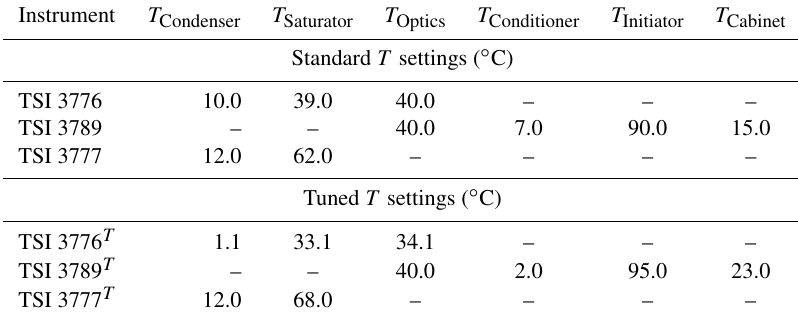
Figure 4. Detection efficiencies of the butanol-based CPCs: the figure shows the detection efficiencies as a function of the electrical mo- bility equivalent diameter. Every plot corresponds to a different butanol-based CPC: TSI 3772 (a) , TSI 3776 (b) , Airmodus A20 (c) and TSI 3776 T (d) . Table 2. Temperature settings: the table summarizes the standard temperature settings according to the user manuals of the particle counters and the empirically derived tuned temperature settings (see also Brilke et al.,